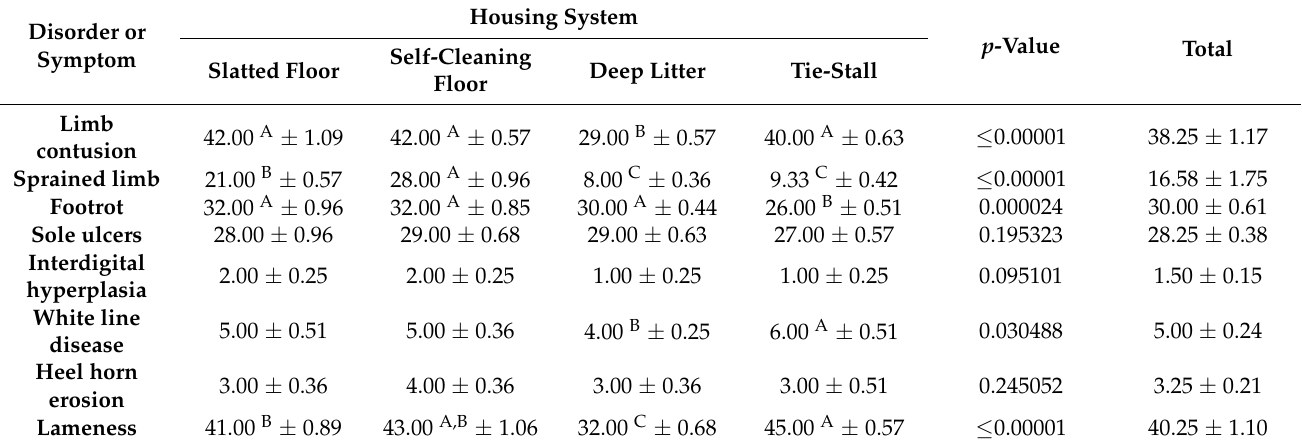
Table 4. Limb disorders affecting dairy cows kept in different housing systems in 2015–2020 (mean ±